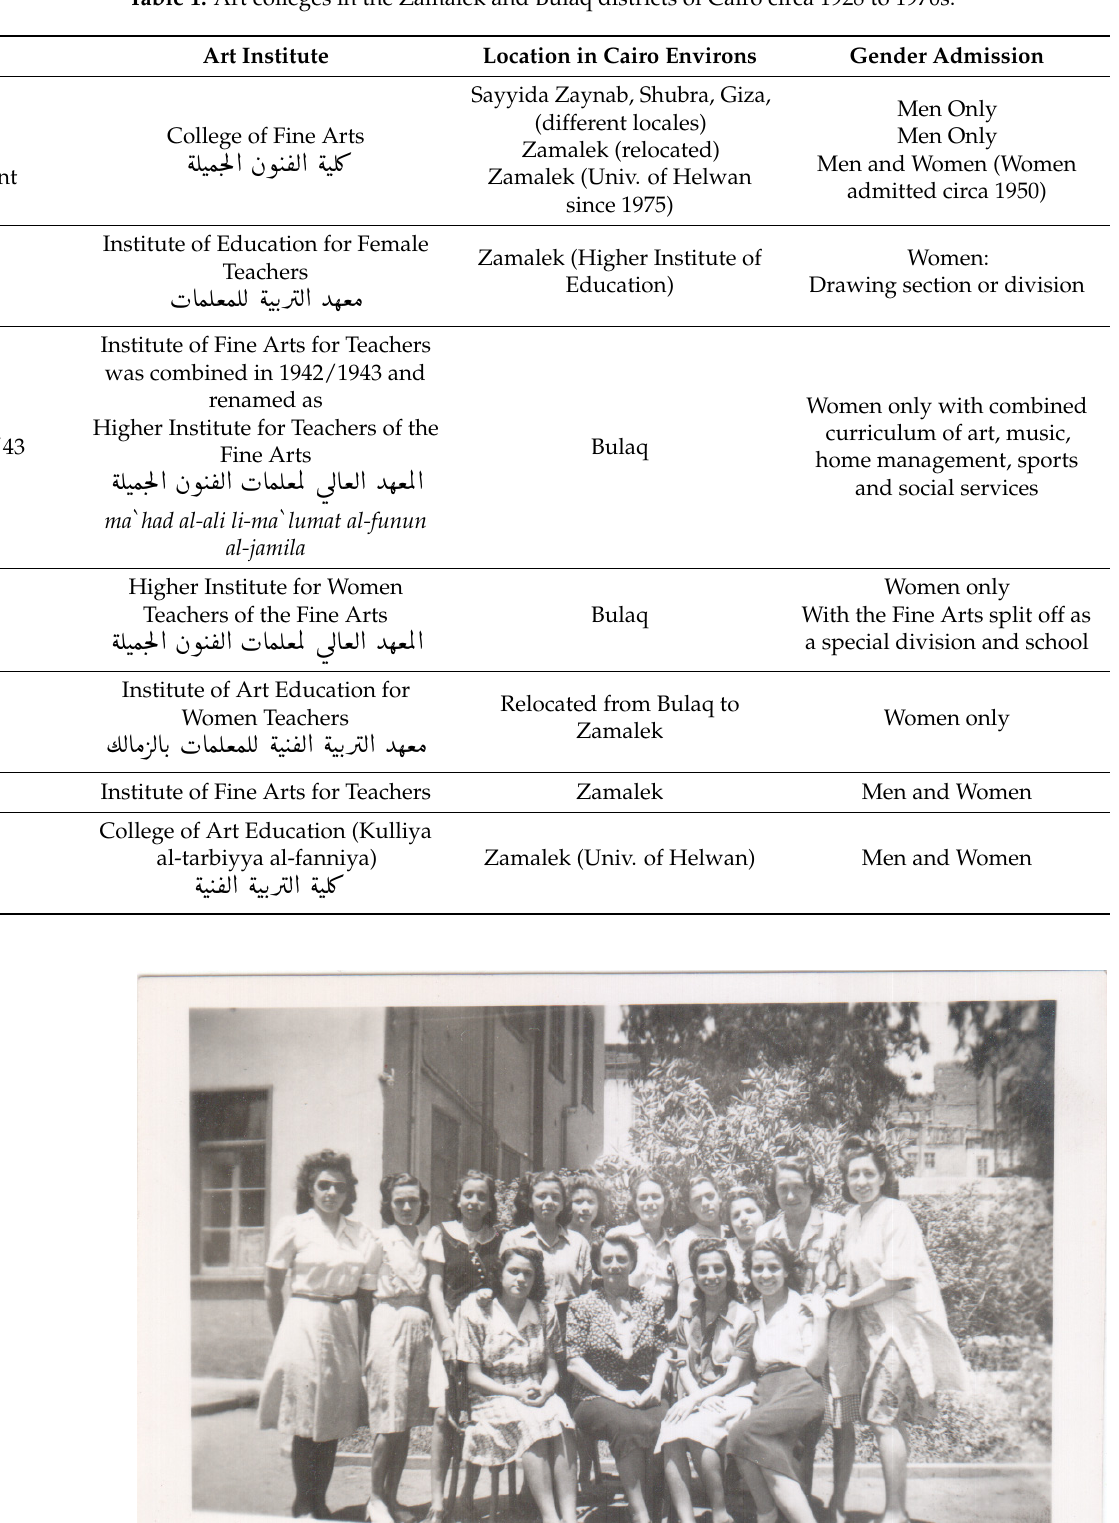
Table 1. Art colleges in the Zamalek and Bulaq districts of Cairo circa 1928 to 1970s.